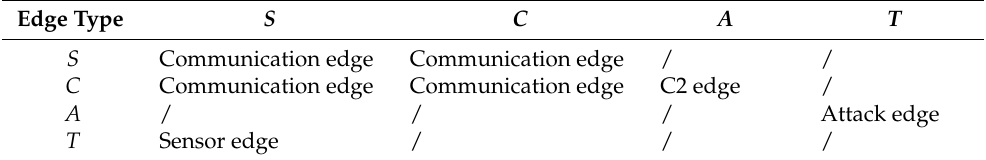
Table 1. Types of edge between